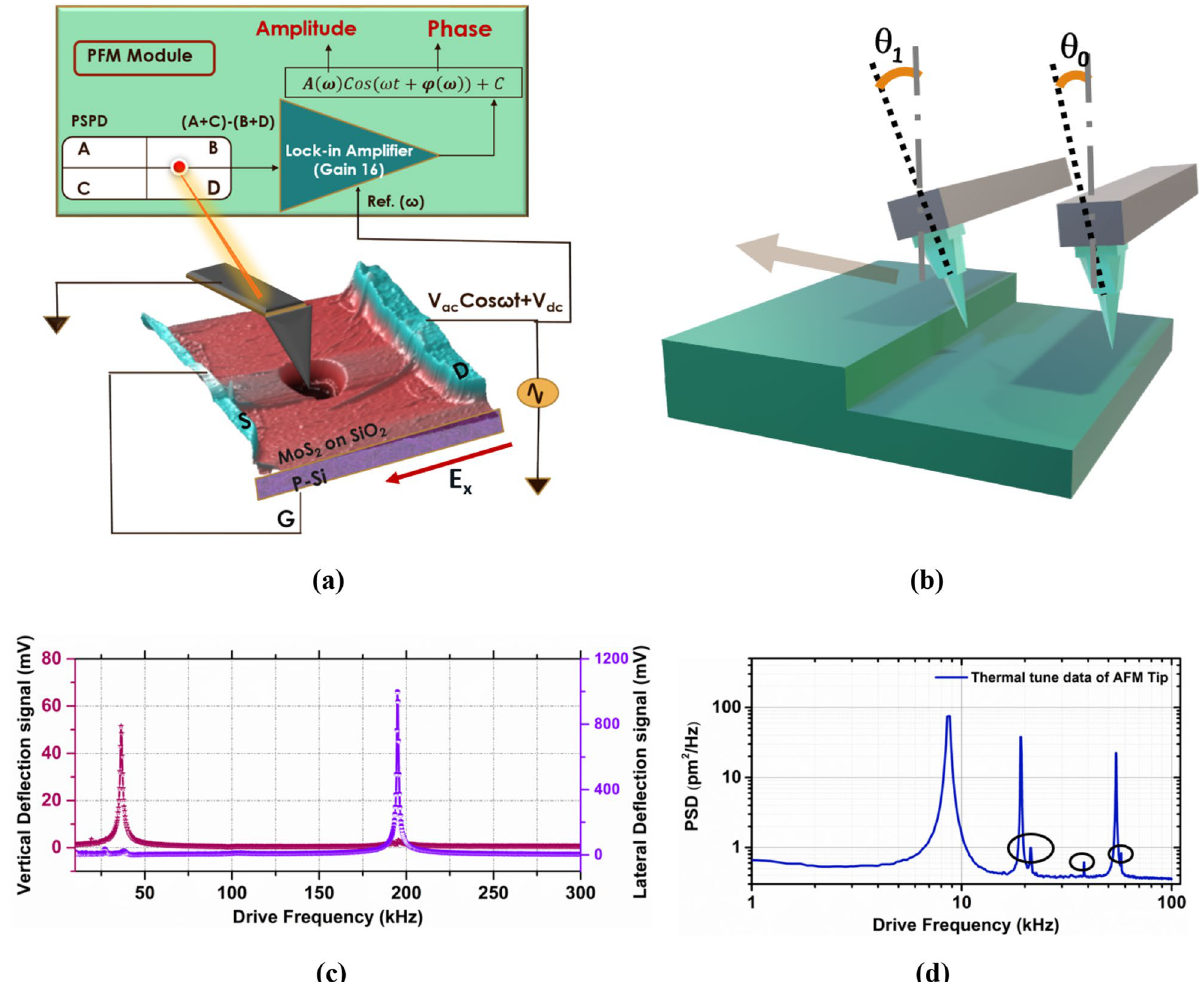
Figure 2. ( a ) Schematic of lateral PFM system with in-plane excitation (S, D, and G refer to the source, drain and gate respectively, p-Si refers to a silicon substrate with acceptor doping/p-type and dimensions not to the scale). ( b ) Schematic explaining angle conversion factor method for lateral deflection sensitivity calibration (arrow indicates the direction of scanning). ( c ) The vertical and lateral frequency response of the AFM cantilever when the tip is in contact with the sample. ( d ) Power spectral density (PSD) during the thermal tuning of AFM tip (free vibrations). The circled regions indicate the electronic noise peaks related to the